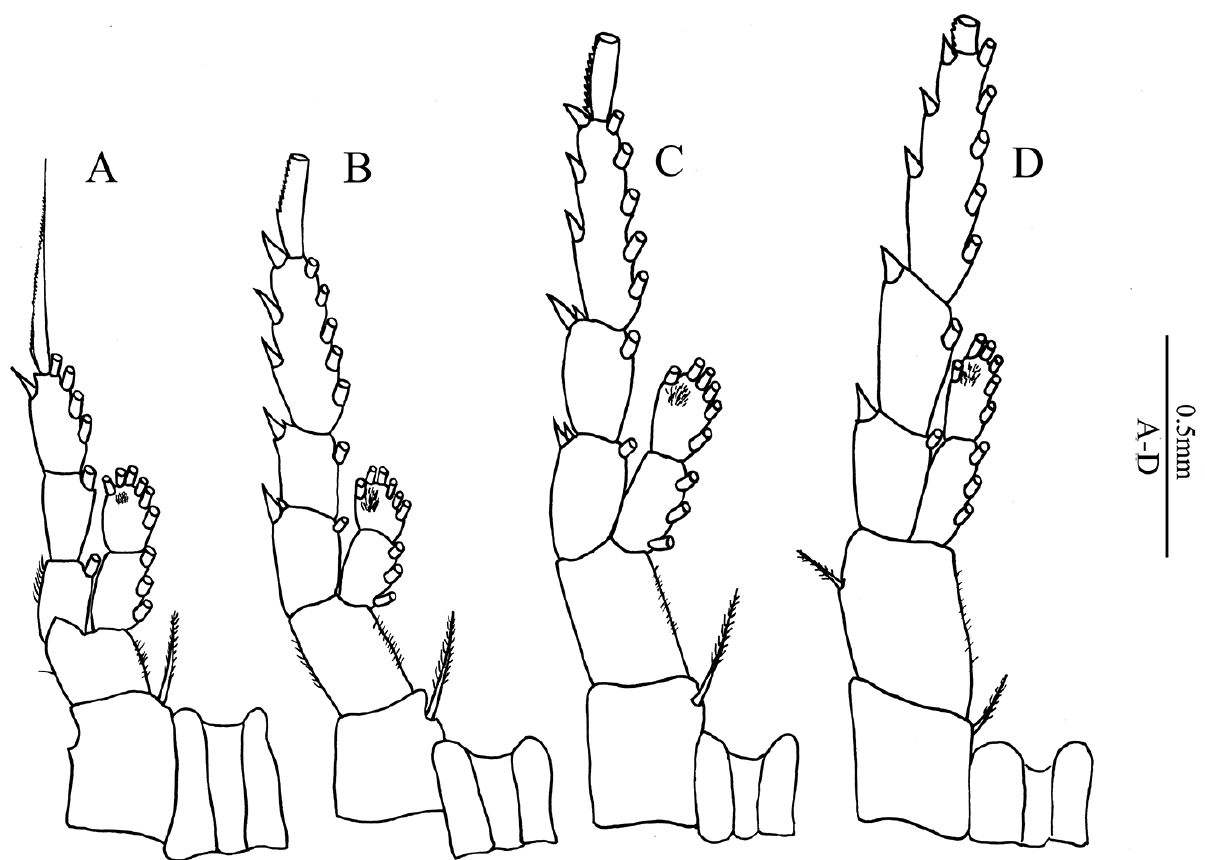
Figure 3. Tortanus ( Atortus ) dhritiae sp. nov., female (holotype), legs 1–4, anterior view: A ) leg 1; B ) leg 2; C ) leg 3; D ) leg